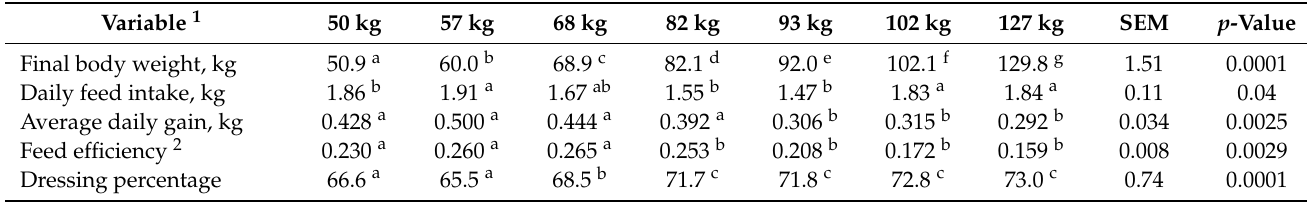
Table 1. Growth performance of Mangalica pigs at different weight